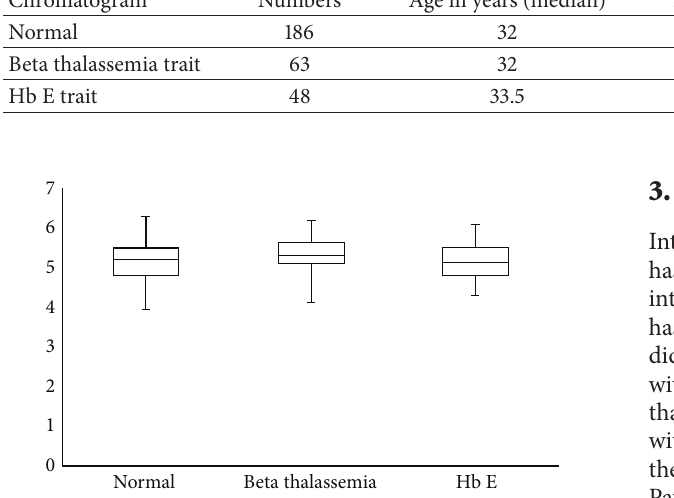
56.8 to 69.0%. Median Hb E+ Hb A2 was 27.3% with a range from 20.4 to